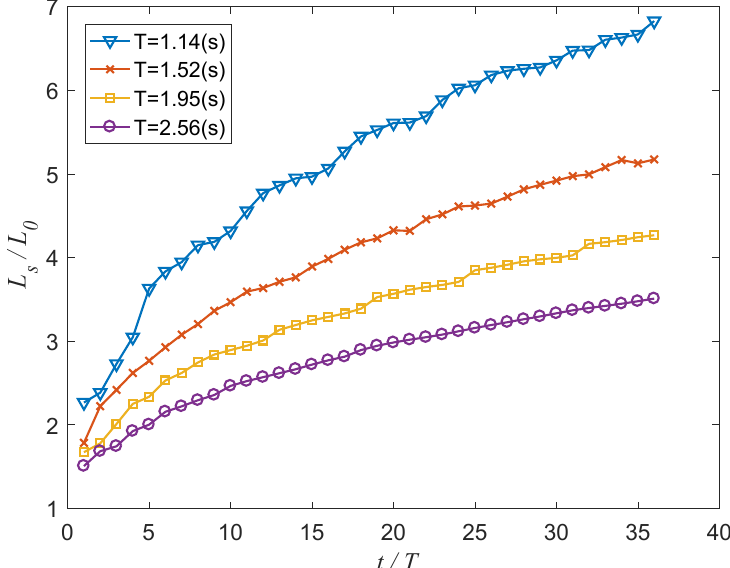
Figure 10. Variation of wave length versus time (period) of the leading wave.